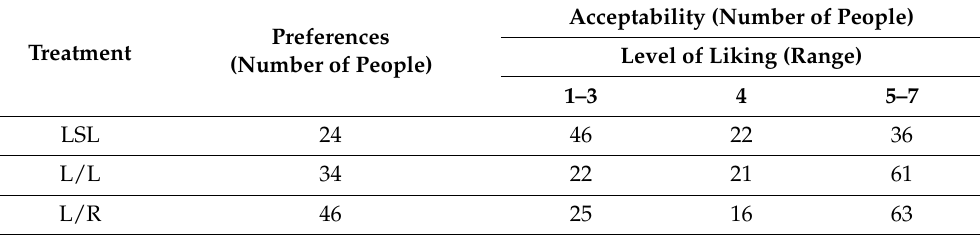
Table 1. Preferences and categories of acceptability perceived by the panelists for the fruits belonging to each treatment: long-shelf-life (LSL), Old Limachino Tomato autografted (L/L) and Old Limachino Tomato grafted on Poncho Negro rootstock (L/R).